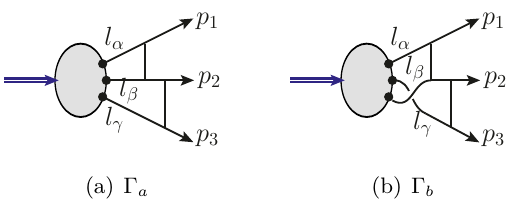
Figure 16. Grouping diagrams in pair for length-three operators. Γ a,b have the same denominator and numerator but the color structures are different. The gray oval represent the trace of the